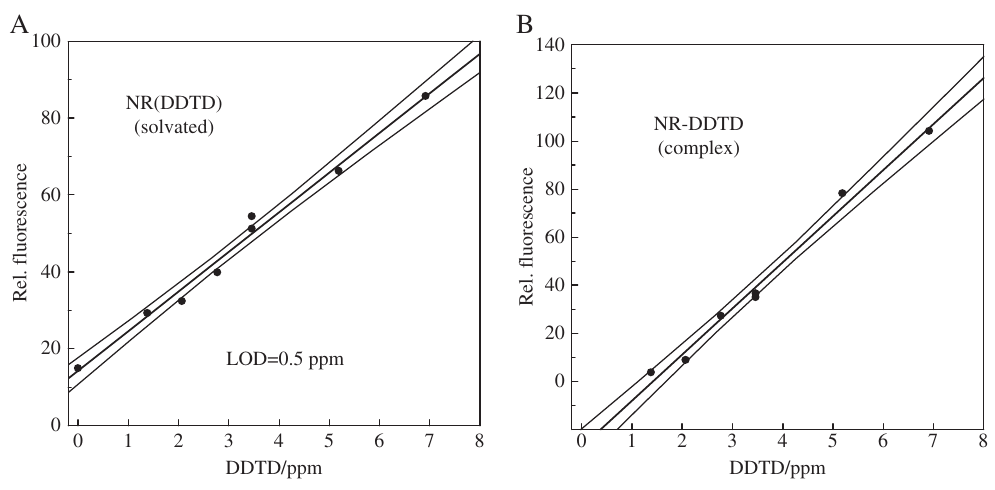
Figure 7 Fluorescence relative intensity of (A) NR(DDTD) (DDTD-solvated NR) and (B) colloidal NR-DDTD complex as a function of DDTD concentration ( Hassoon and Schechter 1998